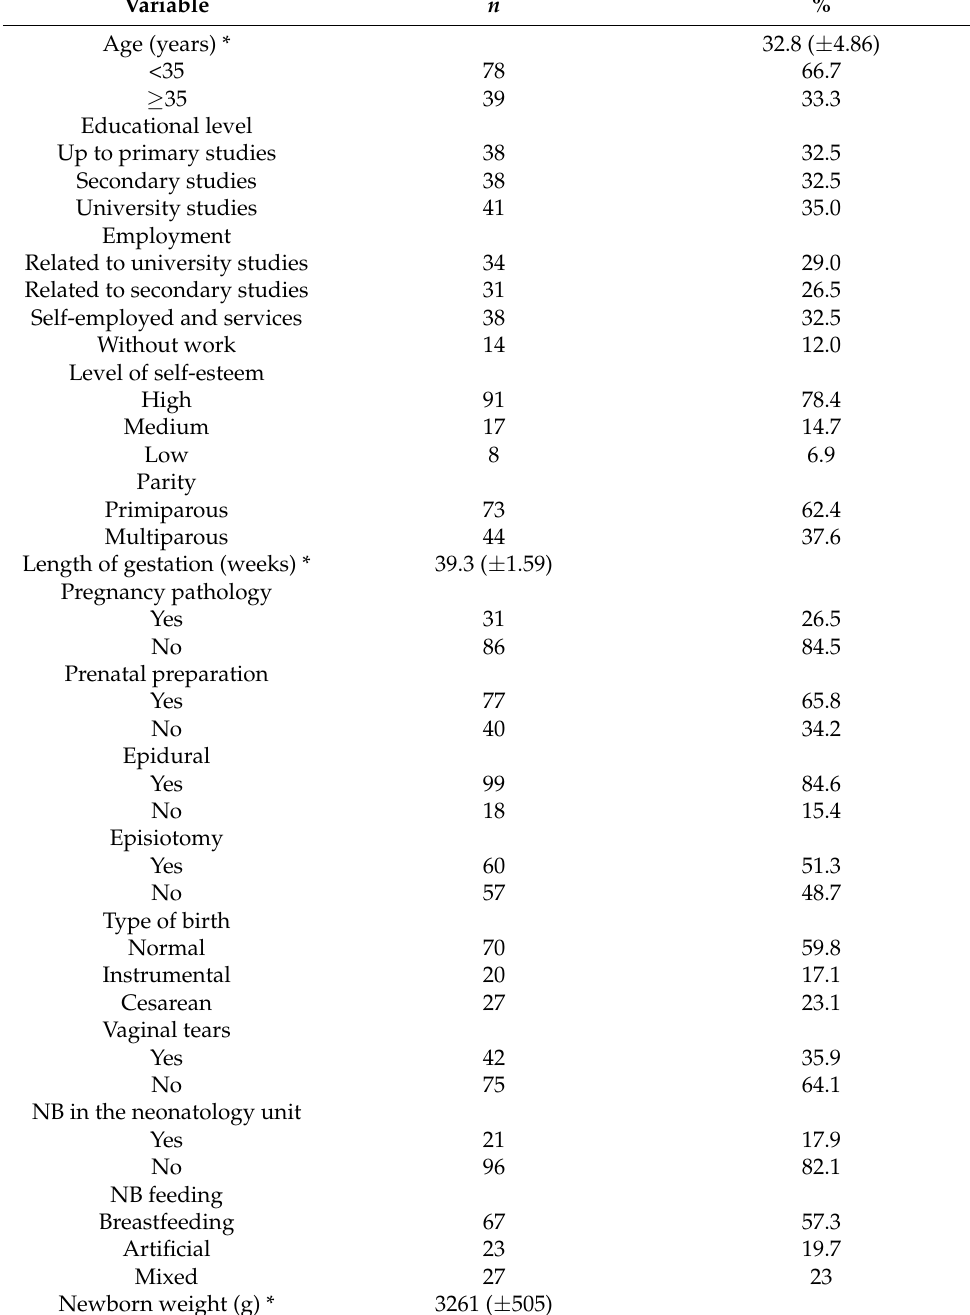
Table 1. Sociodemographic and obstetric characteristics of the women in the study ( N =